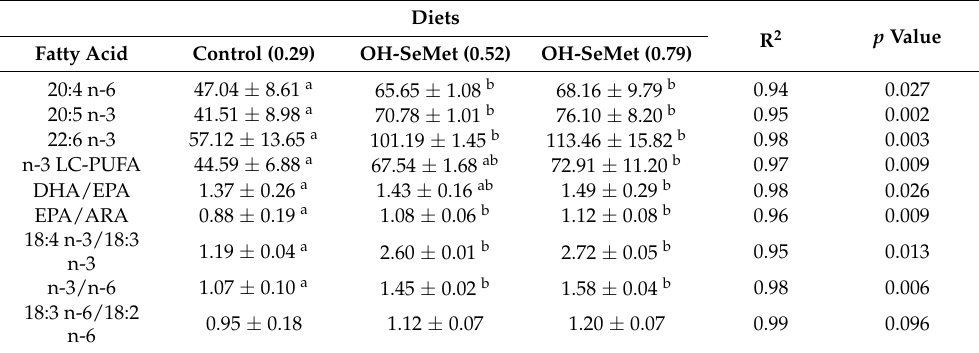
Table 9. Plasma cortisol levels (ng mL − 1 ) in gilthead seabream fed diets with different supplementation of OH-SeMet at 0 and 2 h after the crowding stress challenge. Diets One-Way ANOVA Two-Way ANOVA Plasma Cortisol Control OH-SeMet OH-SeMet p Value Time Se Level (ng mL − 1 ) (0.29) (0.52) (0.79) 0